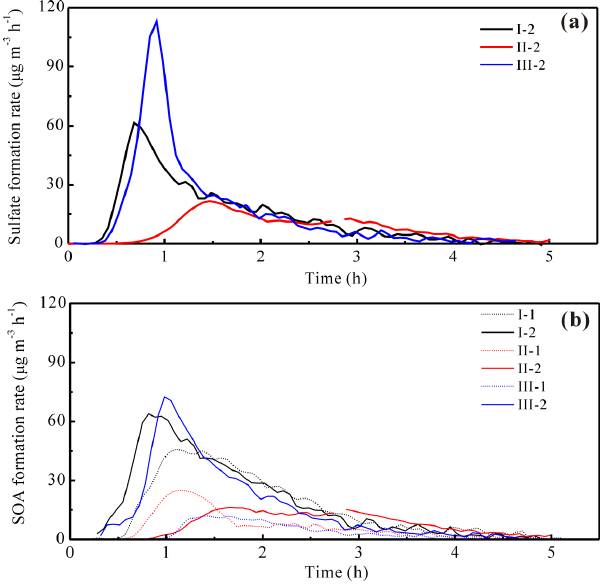
Figure 6. Sulfate formation rates (a) and SOA formation rates (b) as a function of time during the photooxidation of LDGV exhaust.